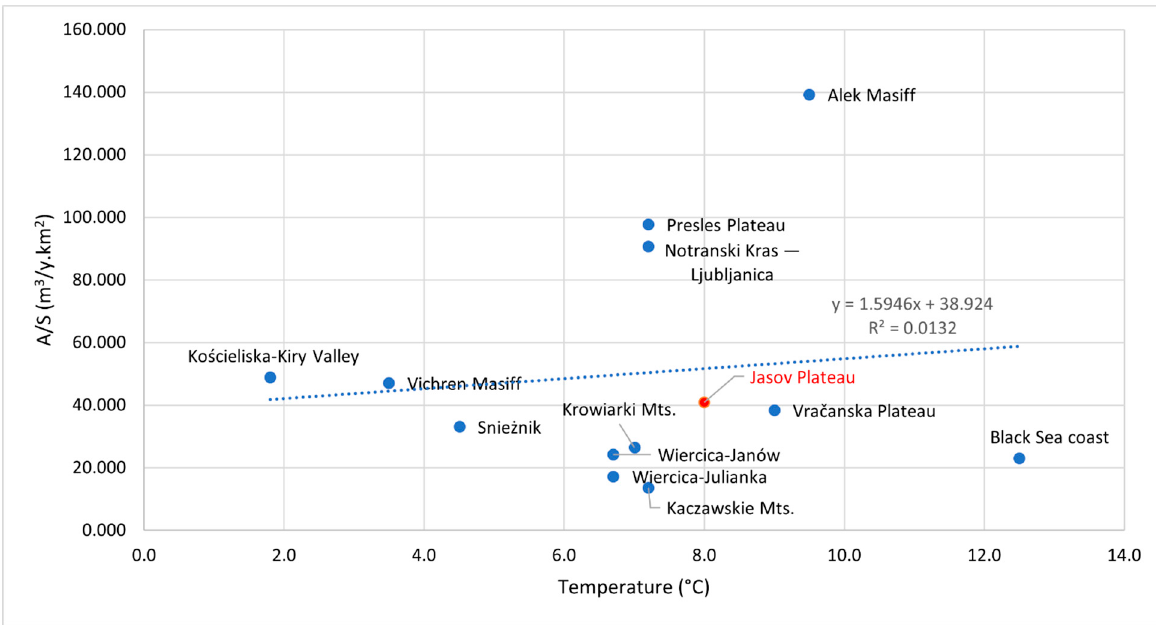
Figure 11. Relationship of air temperature and A/S (ionic runoff/area). Study areas of [5,23] and Slovak Karst, localities described in Table 2.